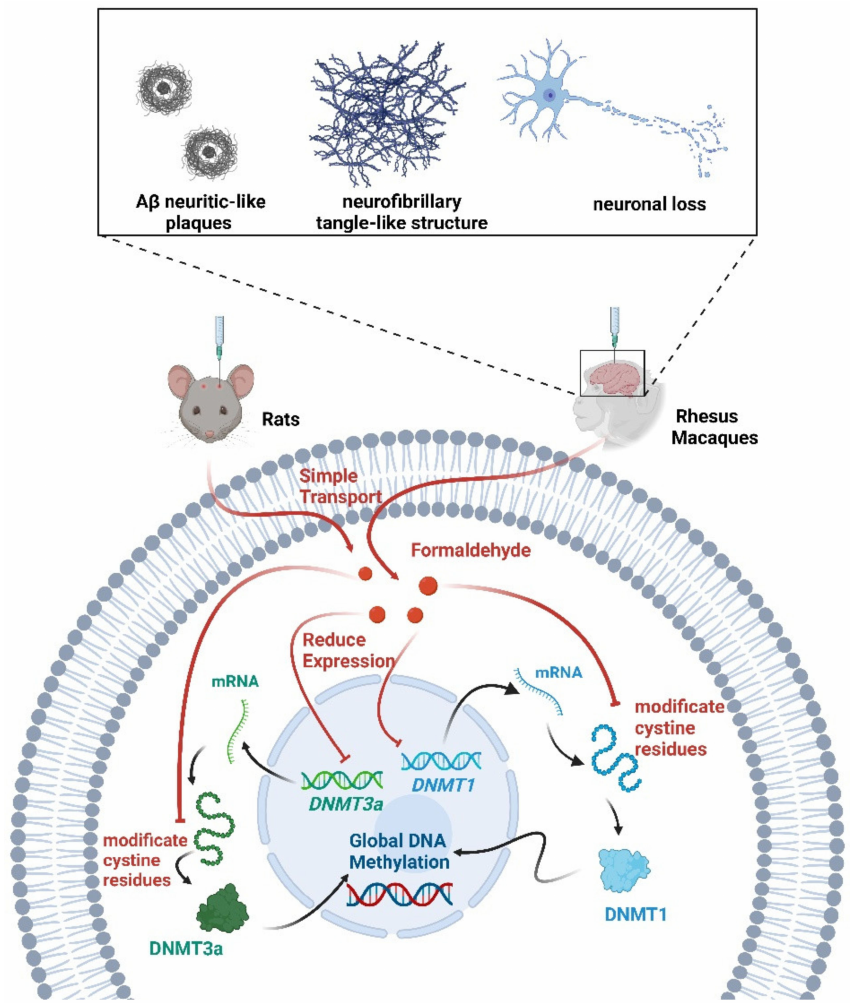
Figure 4. Multiple roles of formaldehyde in methylation. Formaldehyde decreased DNMT1/3a expression and global DNA methylation levels. Formaldehyde also inhibited DNMT1/3a activity by modifying cystine residues. Following the injection of formaldehyde into the brains of rats and rhesus monkeys, the animals exhibited symptoms associated with